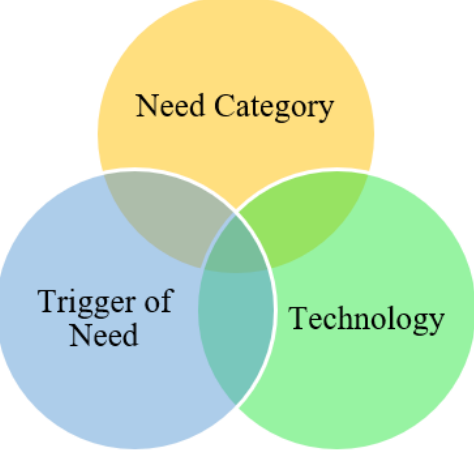
Figure 5. Components for human needs detection.